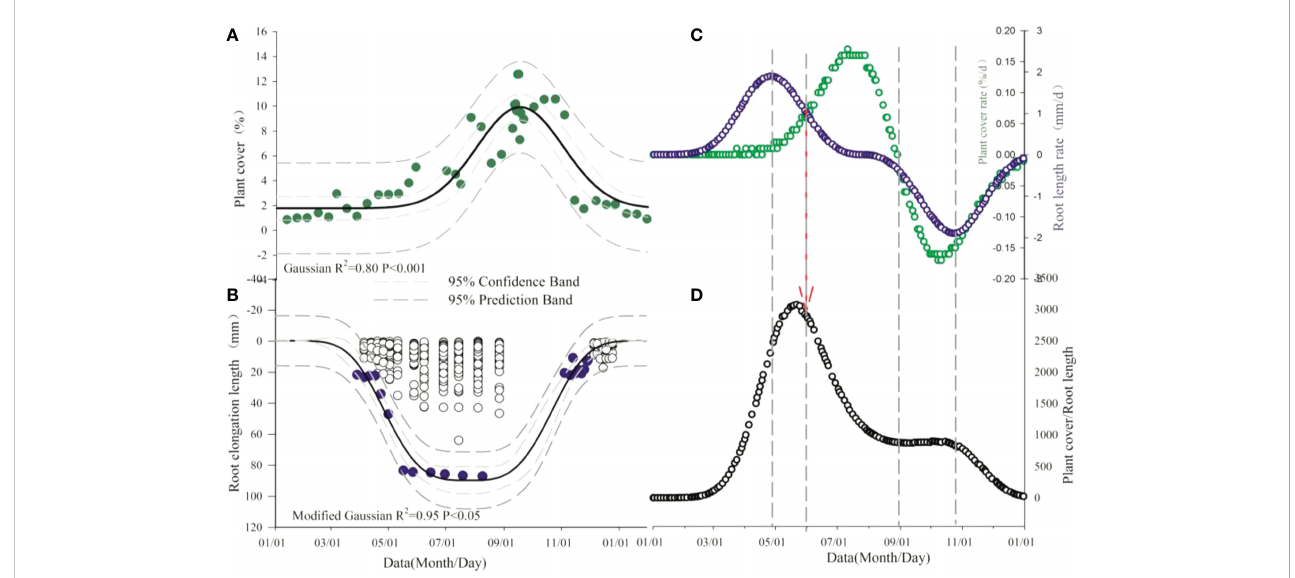
FIGURE 1 Seasonal dynamic of total vegetation cover (A) , root length (B) and growth rate of plant cover and root length (C) and shoot-to-root ratio (D) . Dashed arrows indicate the change point of relation between above- and